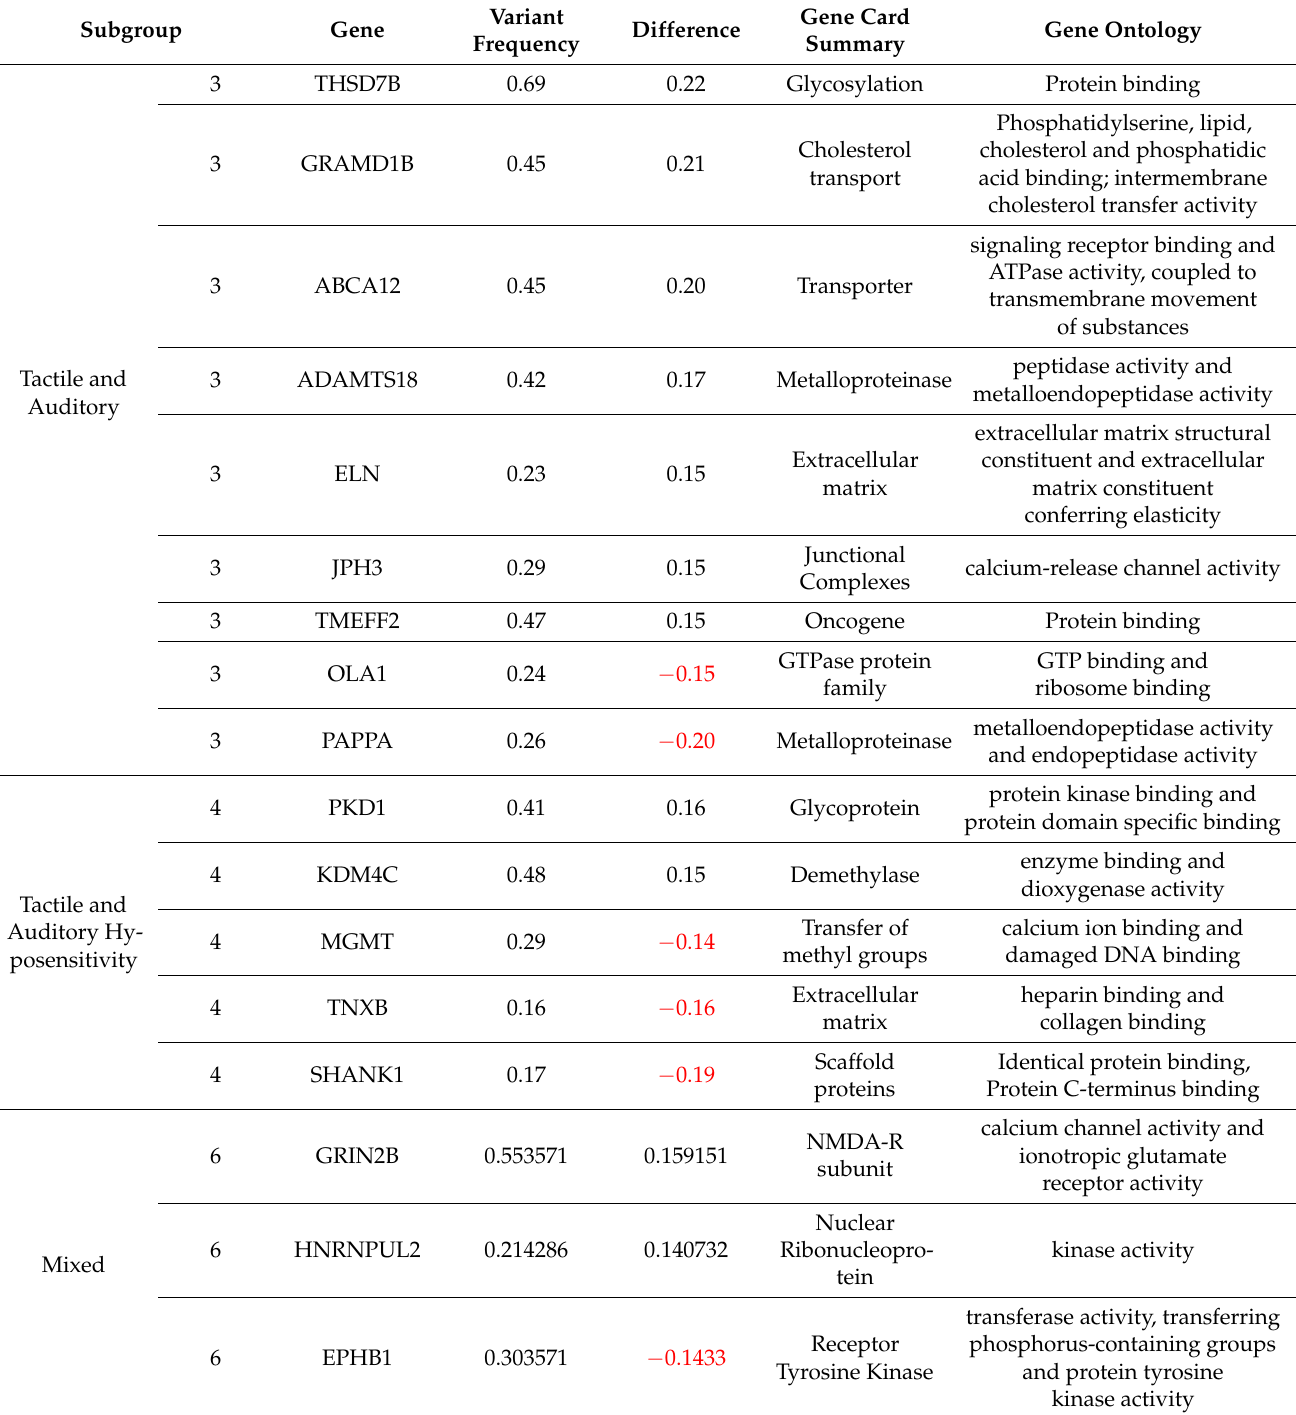
Table 4. Genes with uniquely high variant frequency in subgroups 3, 4 and